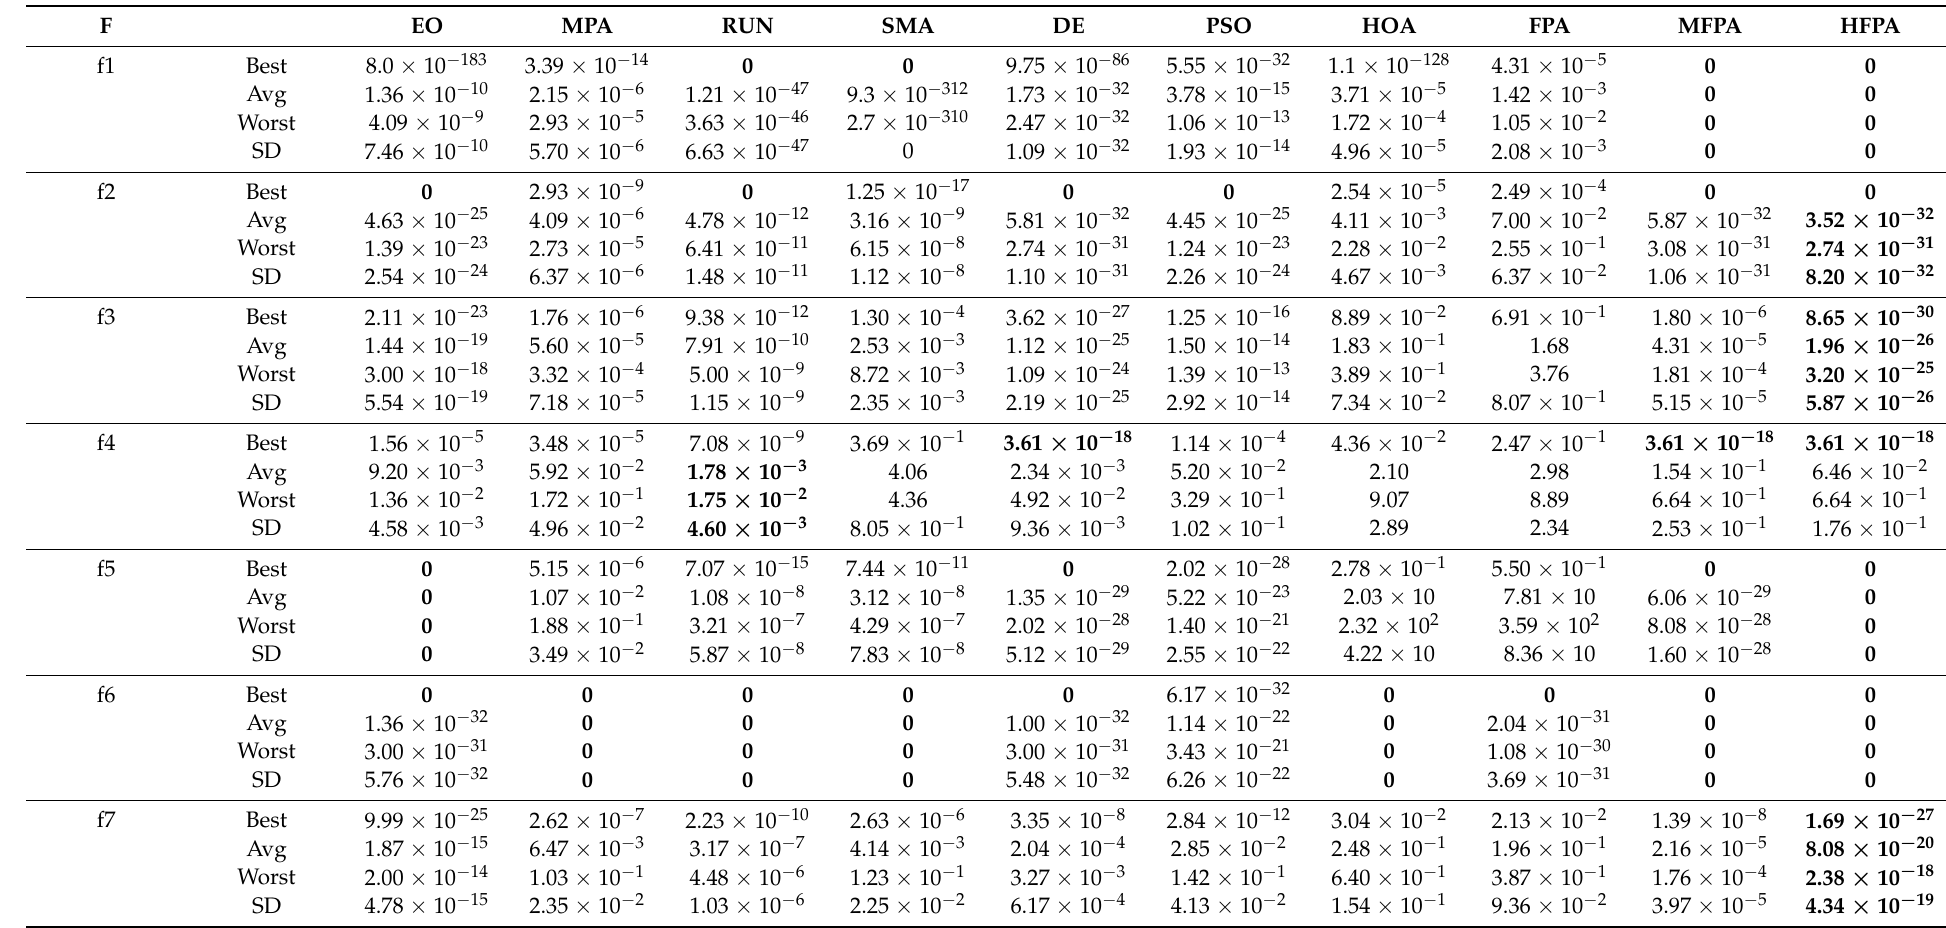
Table 5. Comparison on test cases